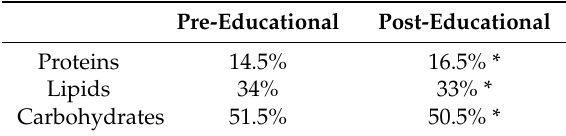
Table 4. Diet composition as macronutrients percentages, before and after the educational